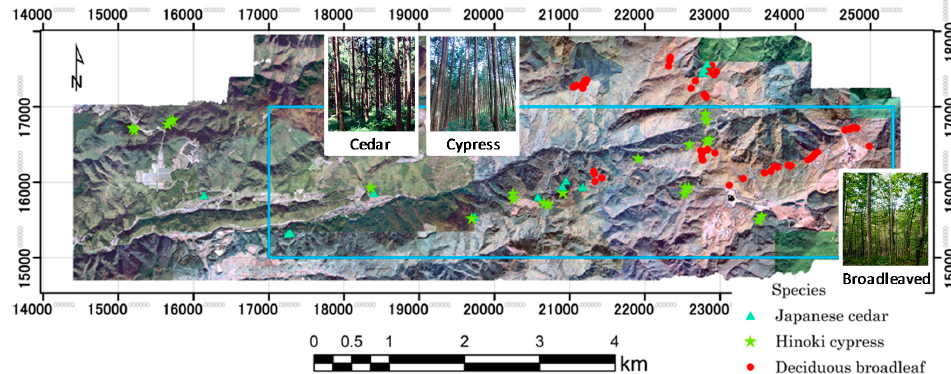
Figure 2. Plot location map. The orthophoto shows the common coverage of three light detection and ranging (LiDAR) data. The blue square area represents the location of the resulting maps of TDB and SV. The three photos show typical stands in the study site. The coordinate system of the map is Japan Plane Rectangular Coordinate System VII. Deciduous trees that had dropped leaves at the time of photo acquisition in 2012 appear in orange.